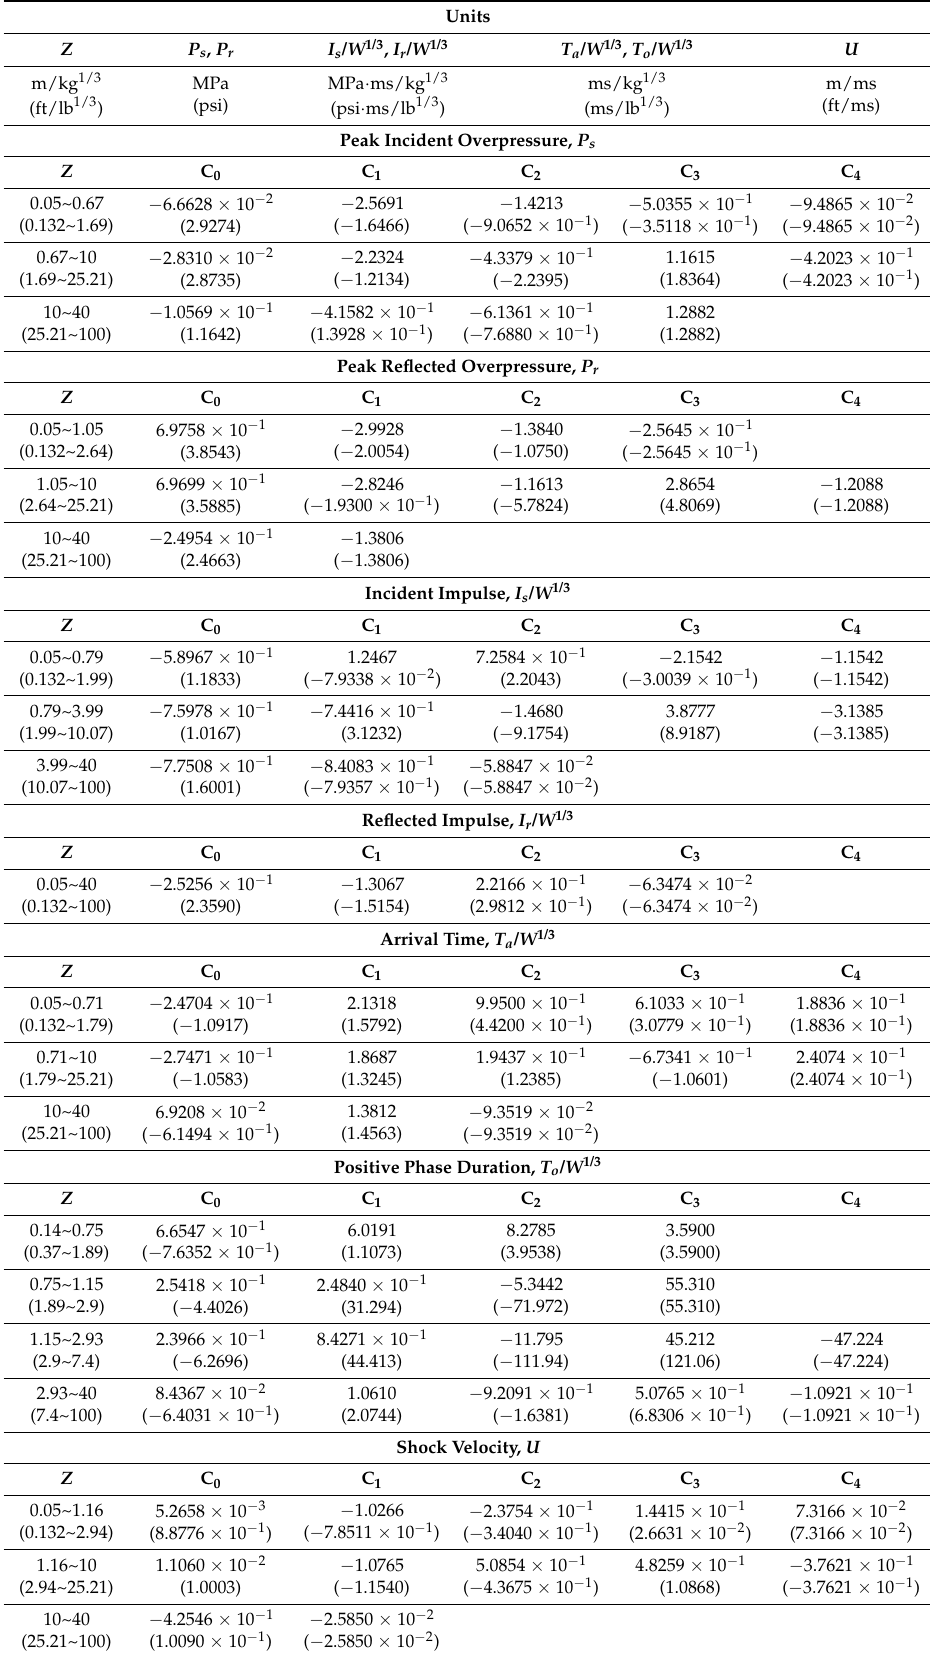
Table 3. Constant of the Modified Equation for Free-Air